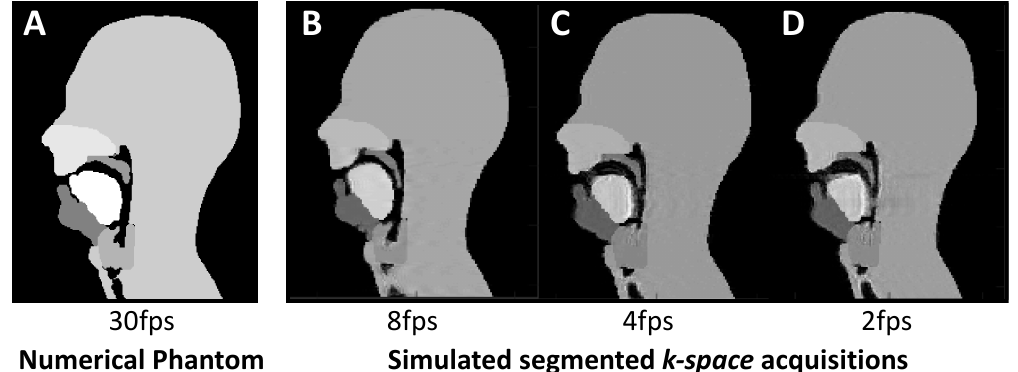
Figure 11. Example frames of the segmented k-space reconstruction at 8, 4 and 2 fps ( B – D ) exhibiting increasing temporal blurring when compared to the 30 fps numerical phantom ( A ).